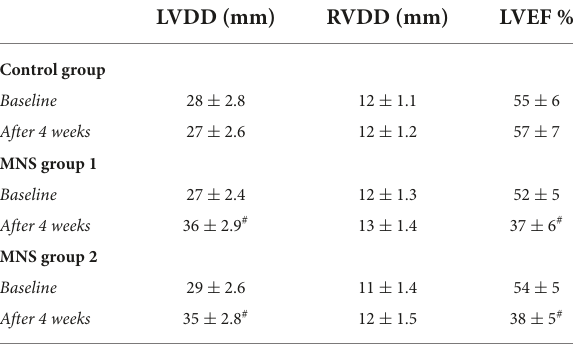
(IL-6), and acetylcholine (Ach) were examined through enzyme- linked immunosorbent assay